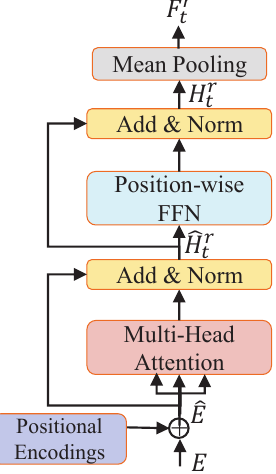
Figure 4. Text relationship semantic encoding